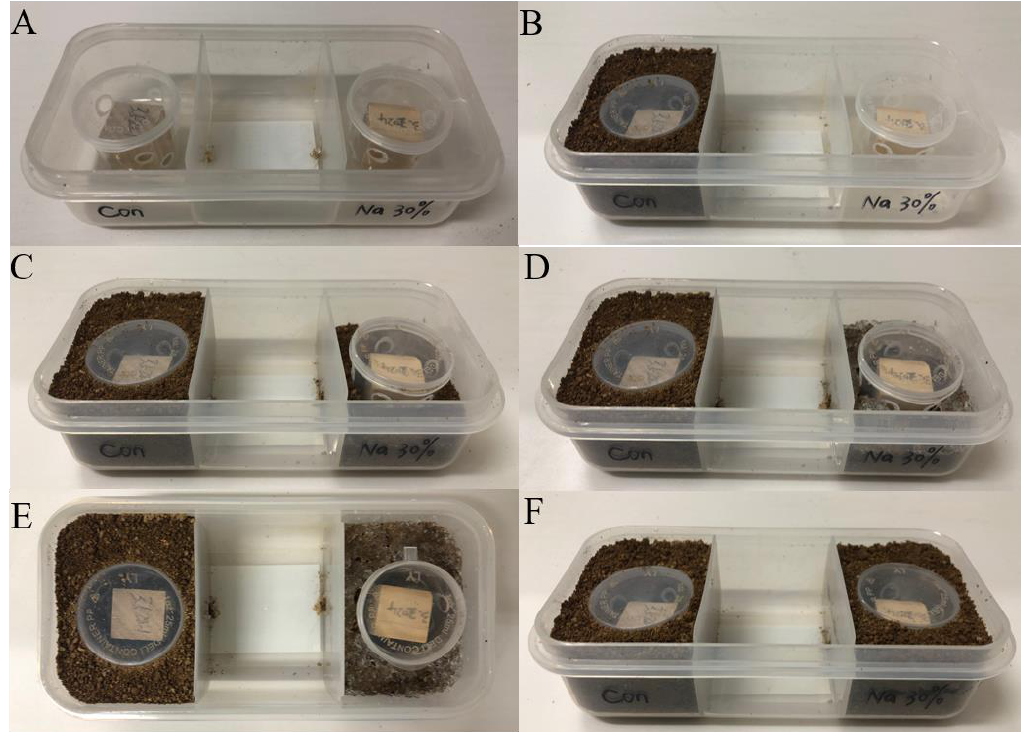
Figure 1. Experiment settings to investigate the preference of termites to super absorbent polymers placed within soil. Baiting containers were placed in the side chambers of bioassay arenas ( A ). The baiting container in one side chamber (randomly assigned) was buried using soil, but the top of the baiting container was unburied ( B ). On the other side, soil was first added to partially bury the baiting container in the depth of 1.5 cm ( C ), and 8 g super absorbent polymers were evenly placed on the surface of soil ( D [side view] and E [top-down view]). Additional soil was then added to bury the baiting container ( F ).